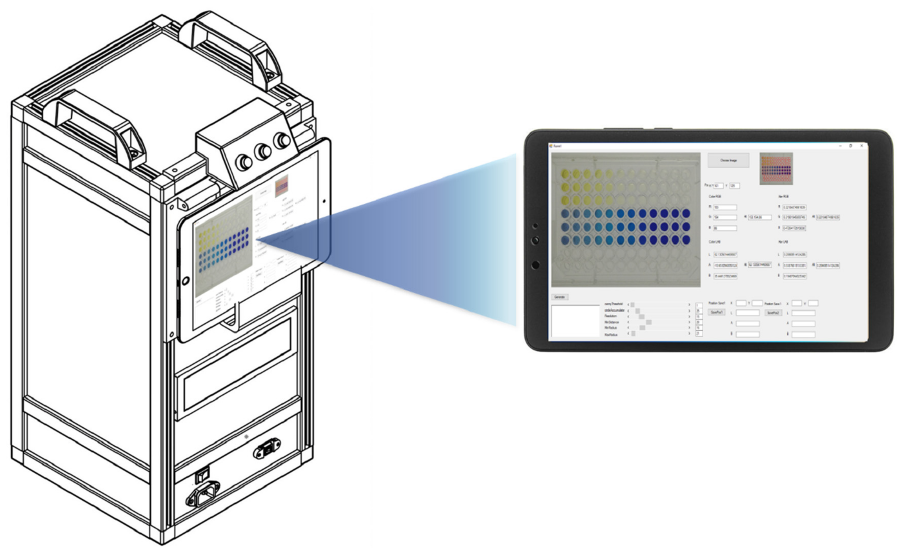
Figure 1. RGB analysis system for the determination of multi ‐ explosives.